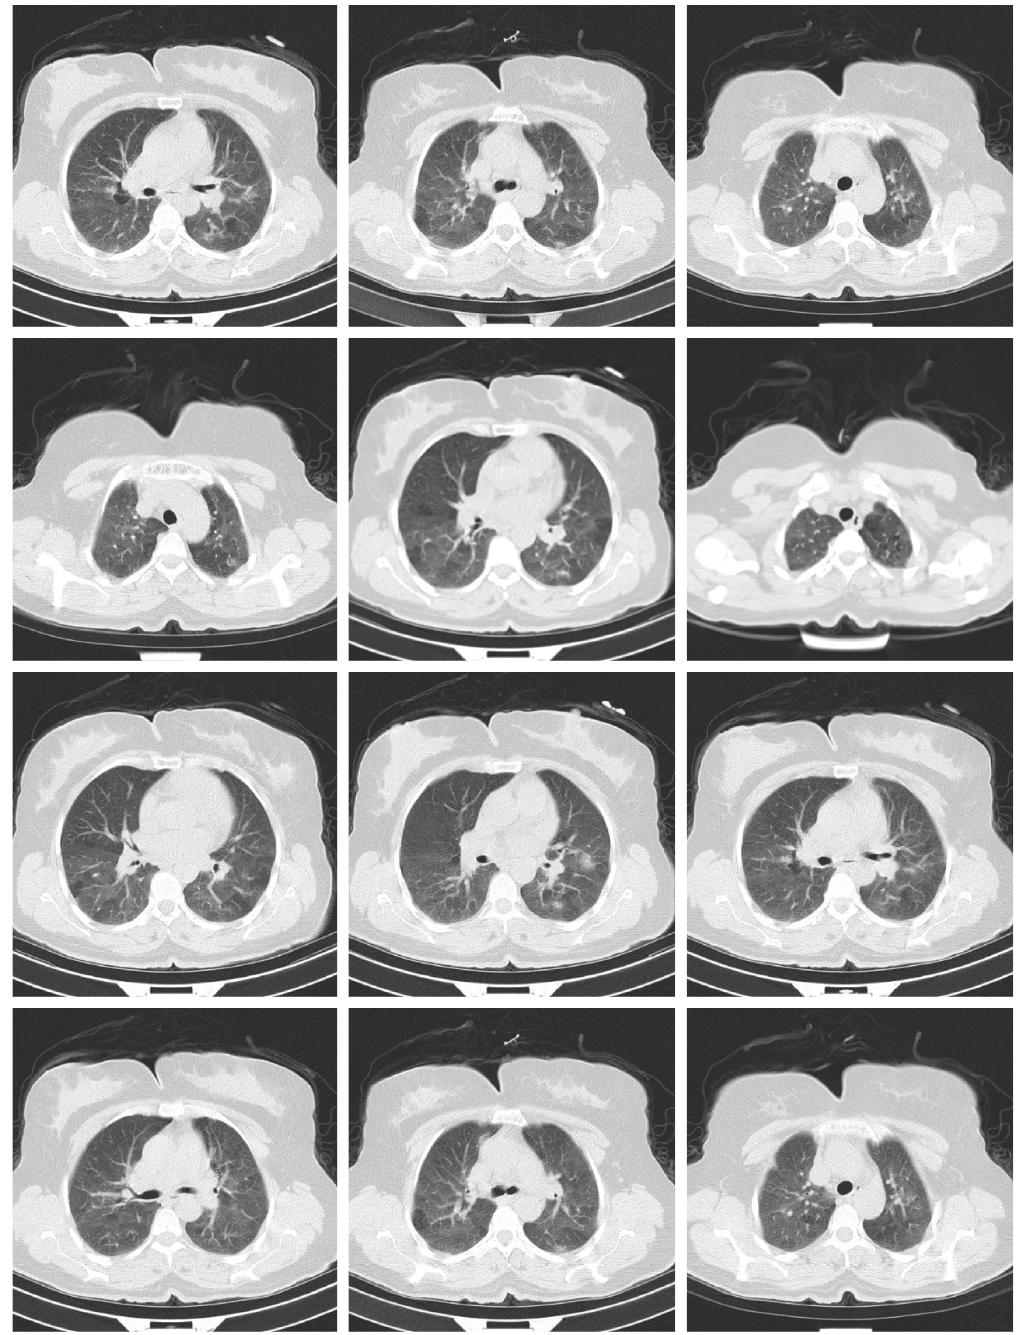
Figure 1: Gallery of some lung CT scan images with COVID-19 dataset